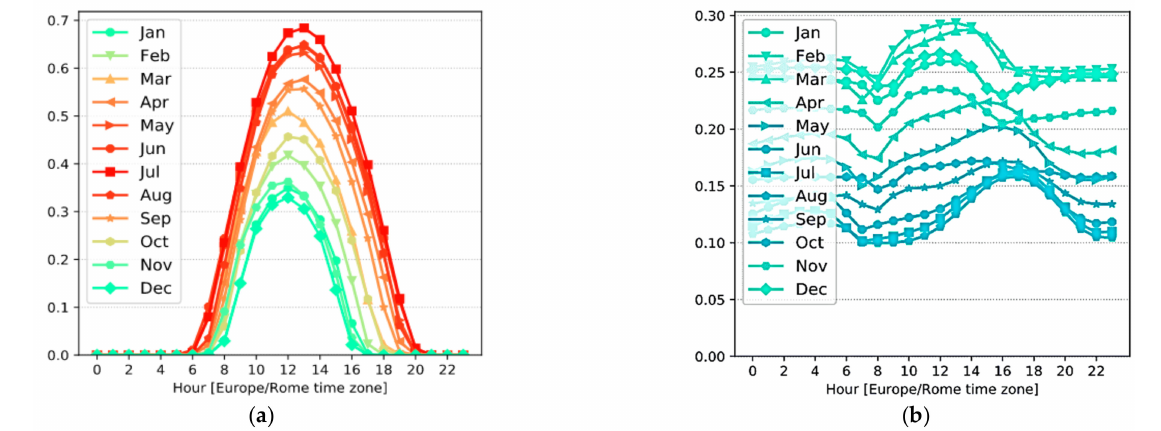
Figure 2. ( a ) Average daily variation of solar power (kW) per installed PV-Ps kWpeak; ( b ) average daily variation of